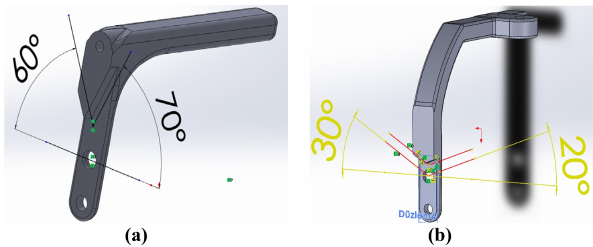
Figure 3. Mechanical limits of the exoskeleton parts for FE and AA